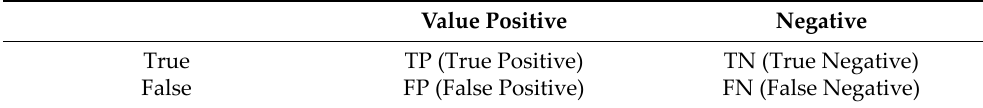
Table 4. Confusion matrix of classification results.